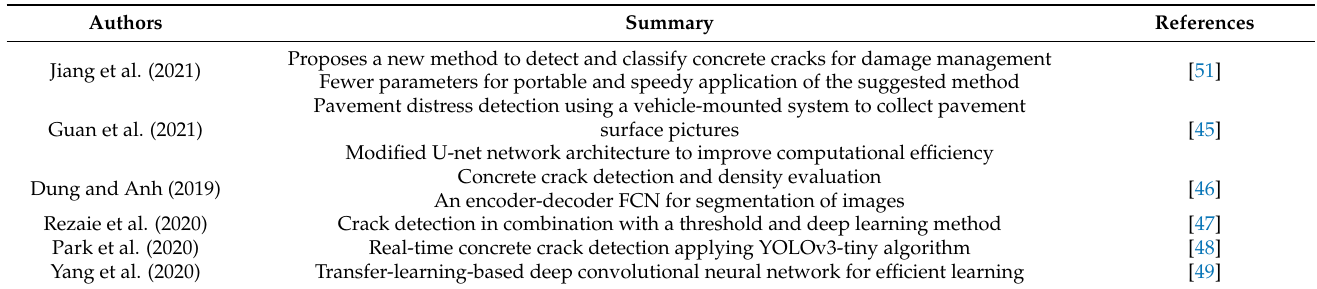
Table 2. Artificial intelligence research on the operation and maintenance of buildings.